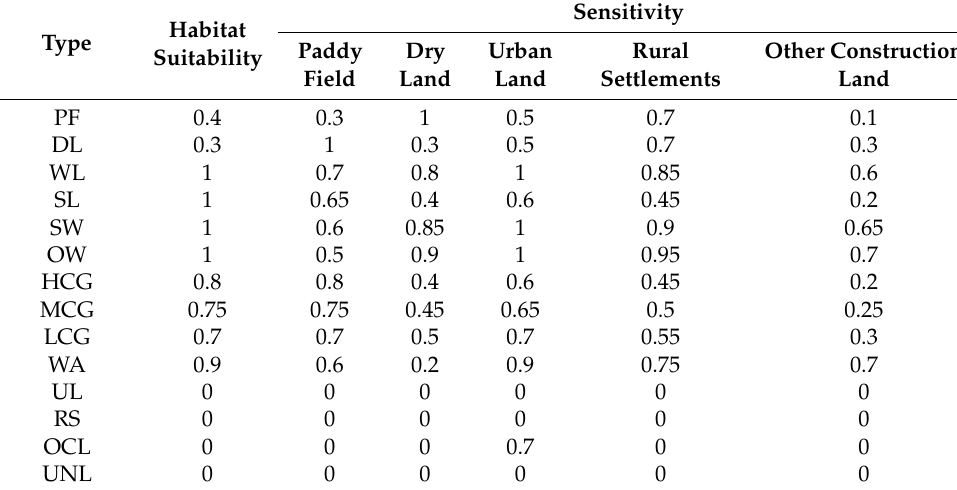
Table 6. Habitat suitability and sensitivity to